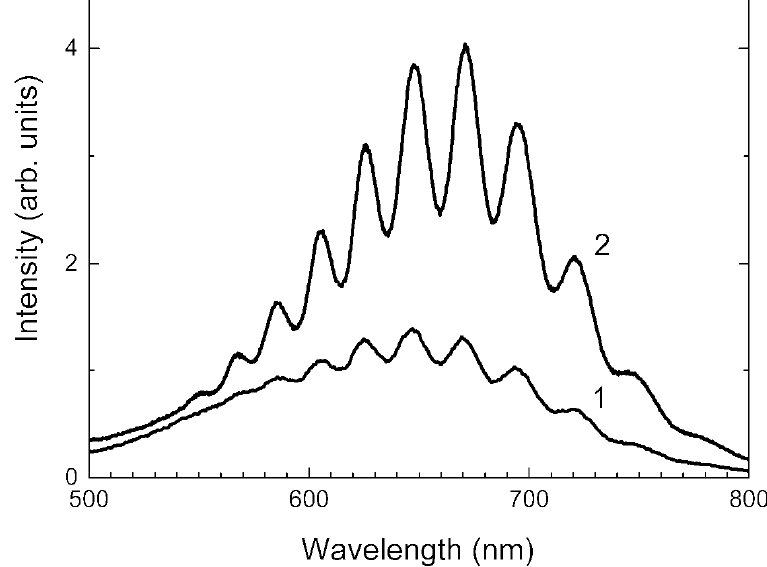
Figure 13. Photoluminescence spectra of the MD sample under 405-nm excitation measured at room temperature (curve 1) and 77 K (curve 2).